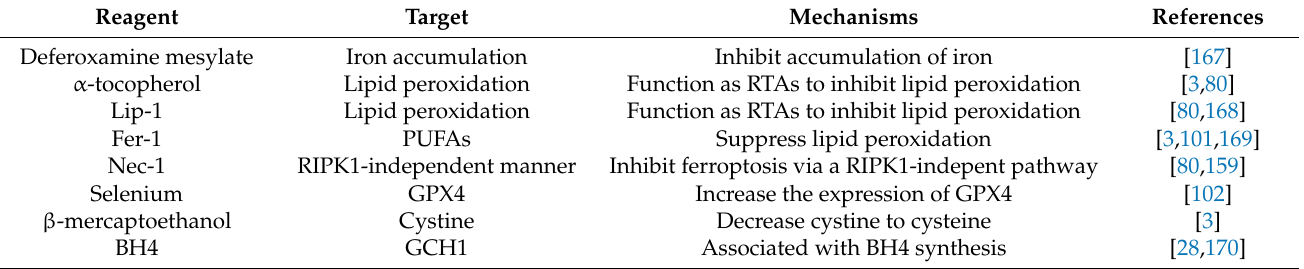
Table 2. Major Inhibitors of